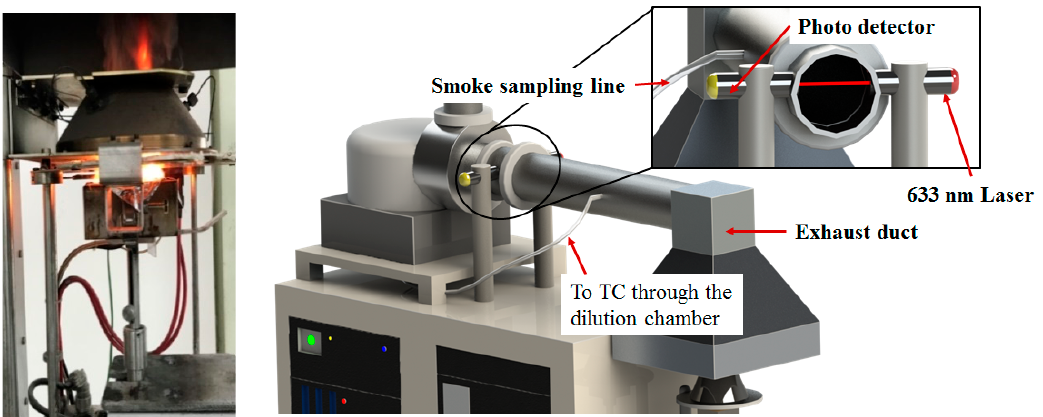
Figure 1. Burning experiments of acrylonitrile-butadiene styrene (ABS) and unplasticized polyvinyl chloride (UPVC) with ISO 5660-1 cone calorimeter. TC: transmission cell.